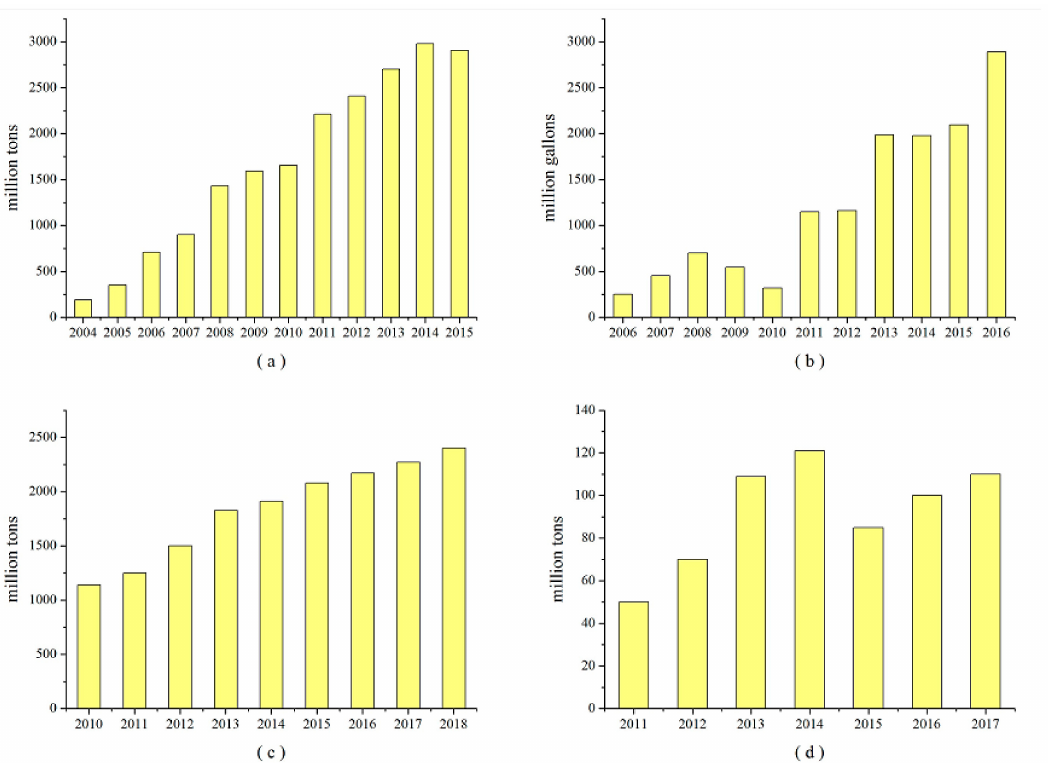
Figure 3. ( a ) Worldwide biodiesel productions; ( b ) US biodiesel market; ( c ) Biodiesel consumption in EU; ( d ) China biodiesel production from 2013 to 2017 [5–7].